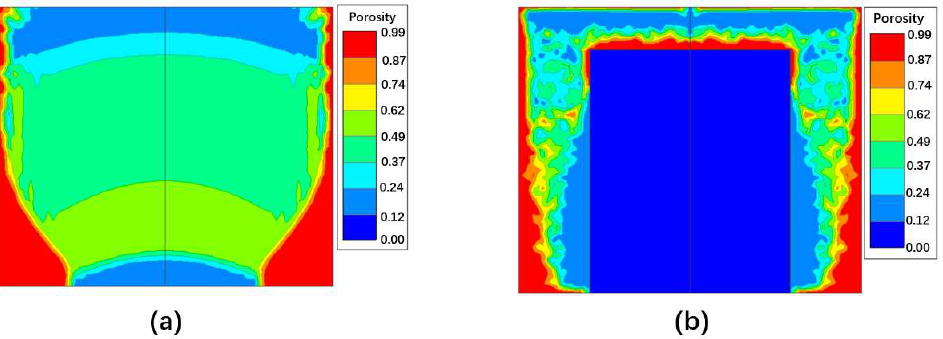
Figure 4. The porosity changes of powder after crystal growth for 50 h in different structures: ( a ) in the traditional structure and ( b ) in the optimized structure.